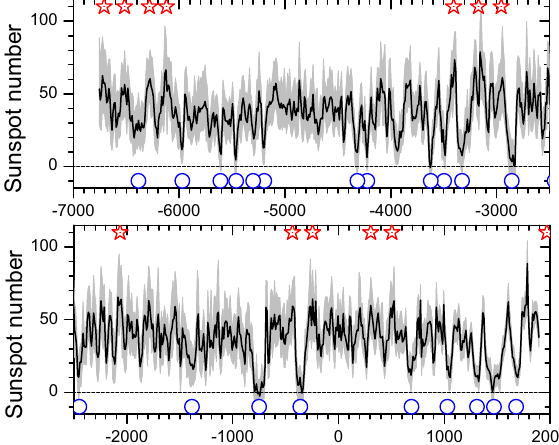
Fig. 20 Sunspot activity (decadal data) throughout the Holocene, reconstructed from 14 C by Usoskin et al. (2016a). Blue circles and red stars denote grand minima and maxima,